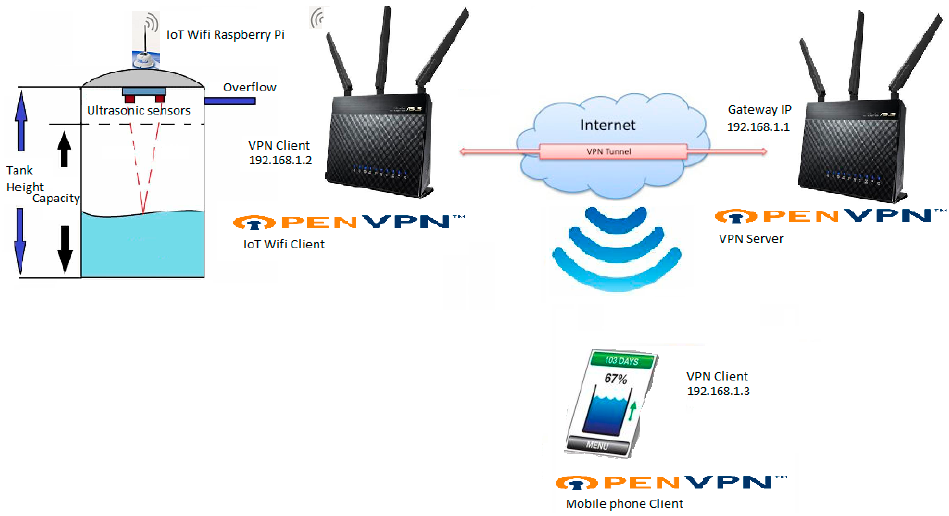
Figure 3. Pilot deployment of the proposed IoT security model for a smart water tank prototype.